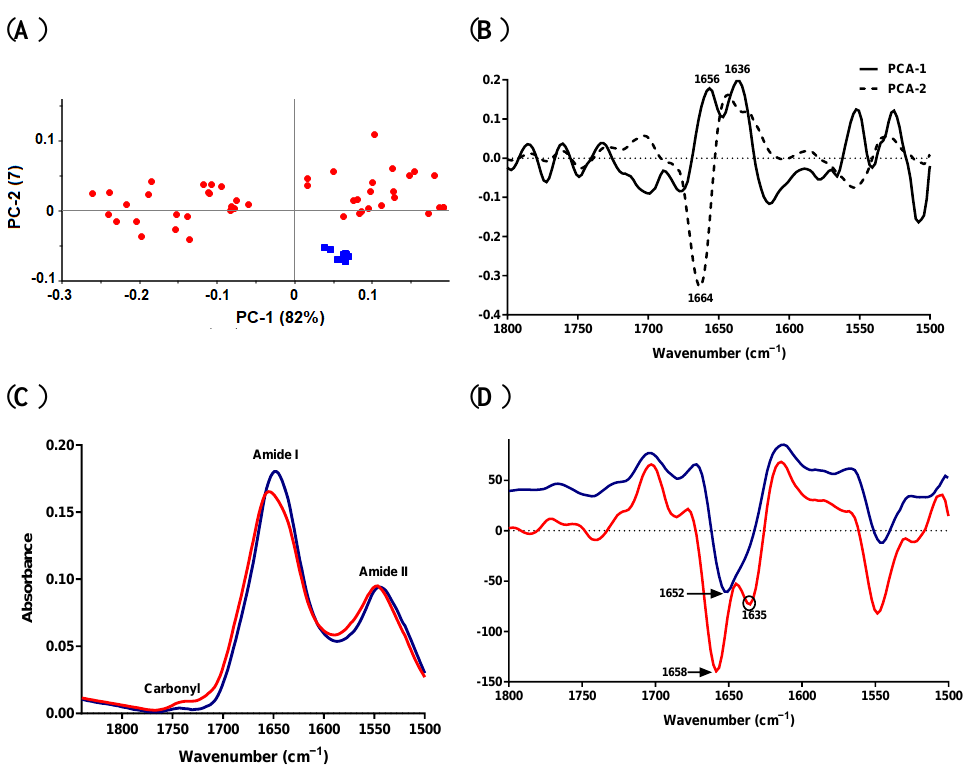
Figure 6. SR-FTIR spectra of the average protein-carbonyl region from S. epidermidis SCV (NSCV, ASCV and LSCV; red) and standard S. epidermidis (blue). ( A ) PCA scores plot. ( B ) Loading plot of PC-1 and PC-2 of PCA model. ( C ) Unit-vector-normalized average raw spectra. ( D ) Normalized reduced Savitzky–Golay second-derivative average spectra.